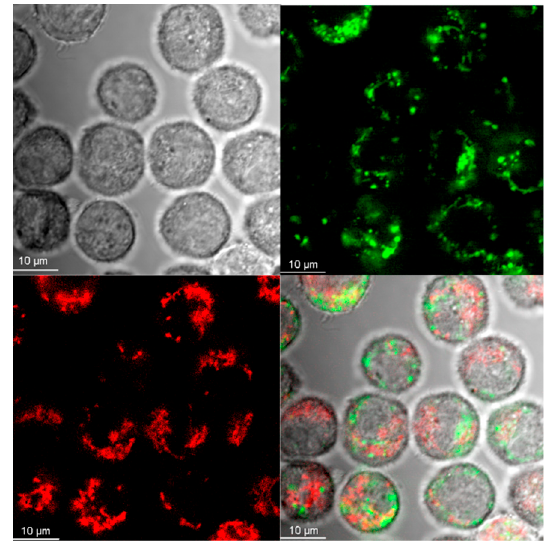
Figure 4. Colocalization of A β -HiLyte Fluor 488 (green) and mitochondrial marker MitoTracker Red (red) in BV ‐ 2 cells. Confocal microscope, magnification 100×.